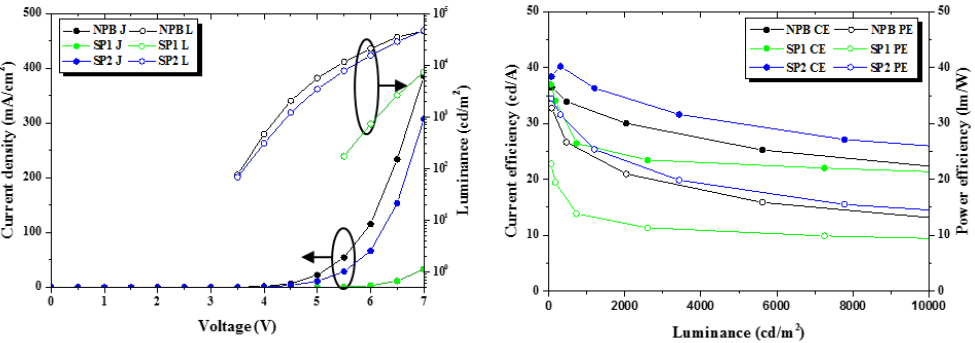
Figure 8. Current density-voltage-luminance (J-V-L) and luminescence current, power efficiency of the fabricated green PhOLED devices.